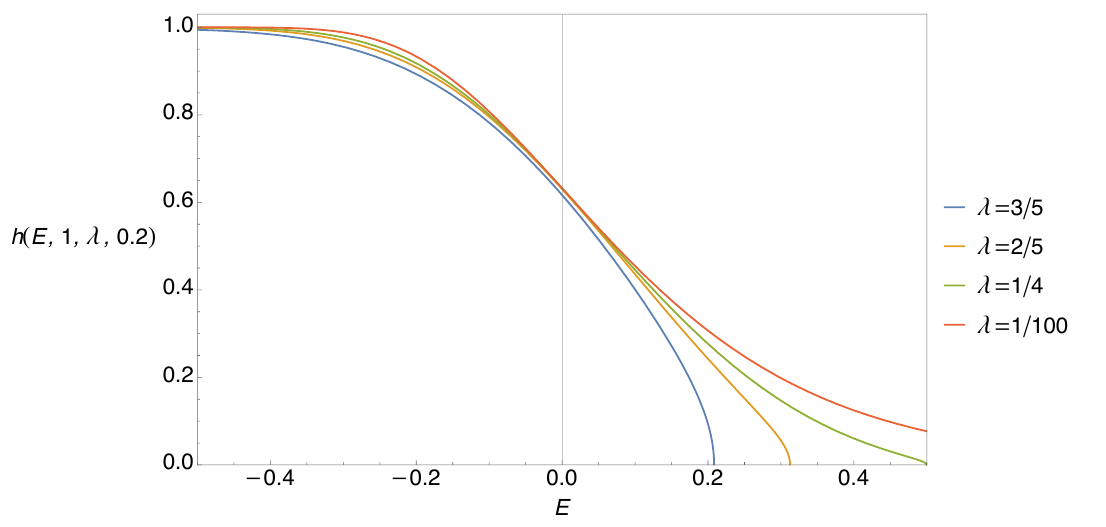
Figure 11. We plot the function h ( E, x, λ, T ) near x = 1 and at T = 0 . 2 . The slope of h ( E, x, λ, T ) changes inconspicuously with respect to the deformation strength λ .